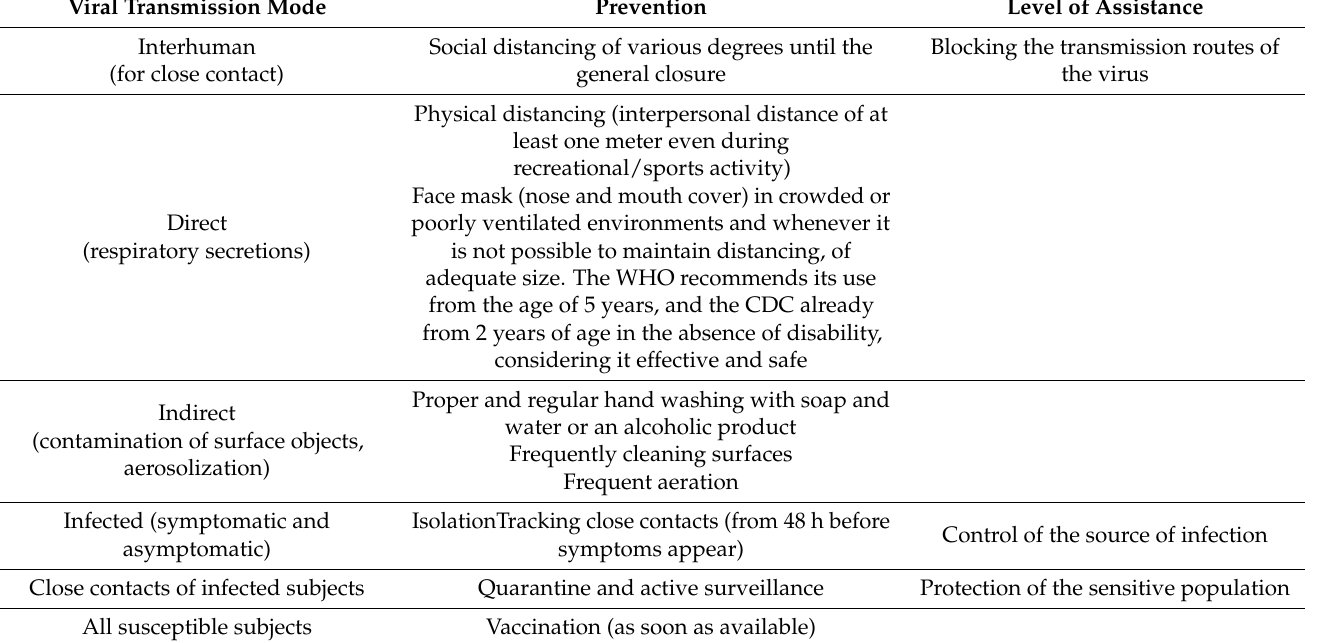
Table 1. Preventive measures currently recommended in pediatric age in relation to SARS-CoV-2 transmission modes. Viral Transmission